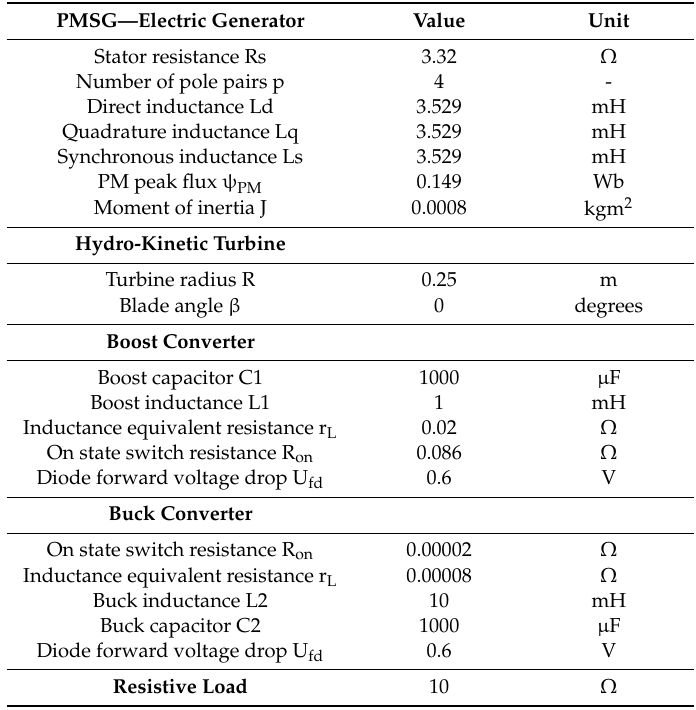
Table 1. Parameters of the components considered for the hydrokinetic turbine system.